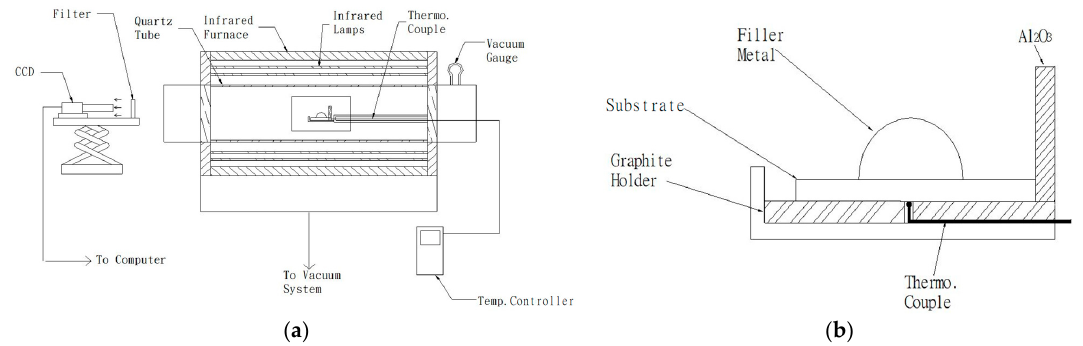
Figure 1. ( a ) Experimental installation of the wetting angle test and ( b ) thermocouple location of the specimen holder in part ( a